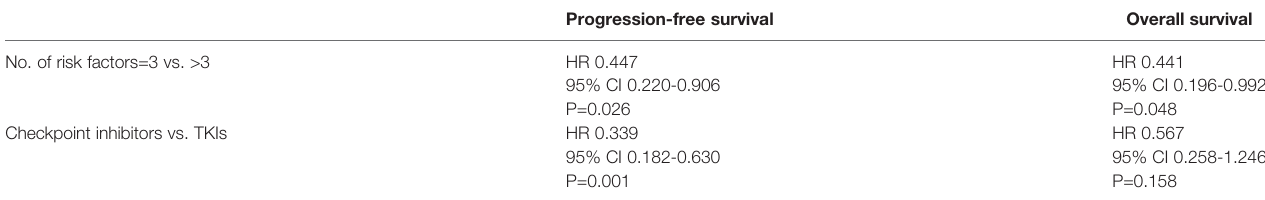
Progression-free survival Overall survival